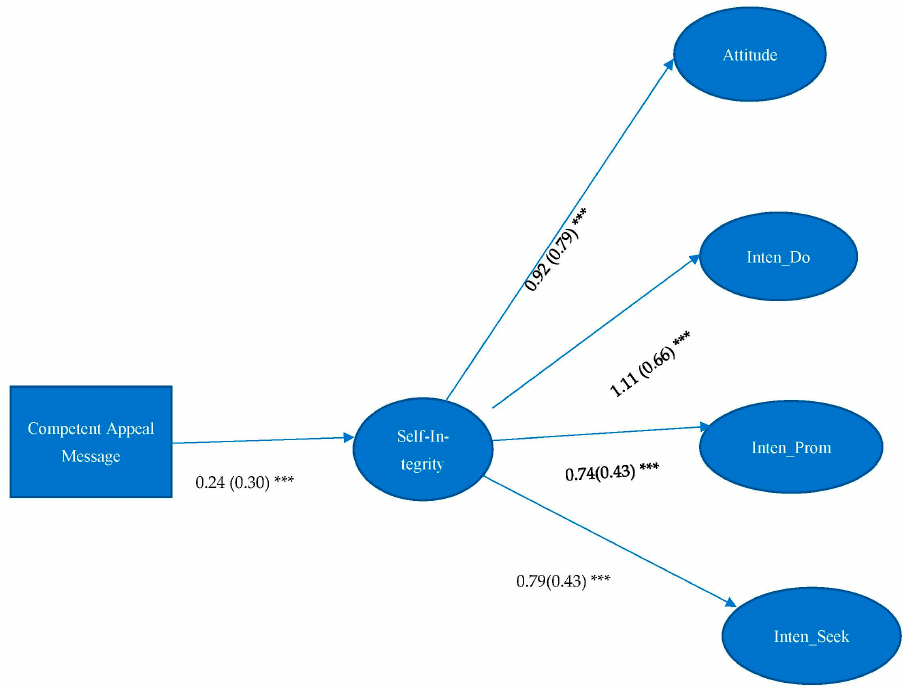
Figure 1. Unstandardized estimates are listed, followed by standardized estimates in parentheses. Model Fit: χ 2 = 443.496, df = 224, p < 0.001; RMSEA < 0.001, 90% C.I.: 0.063–0.084, CFI = 0.920, SRMR = 0.054. Note: *** p < 0.001. Attitude = Attitude toward organ donation, Inten_Do = Intention of be- coming organ donors, Inten_Prom = Intention of promoting organ donation, Inten_Seek = Intention of seeking organ donation-related information.